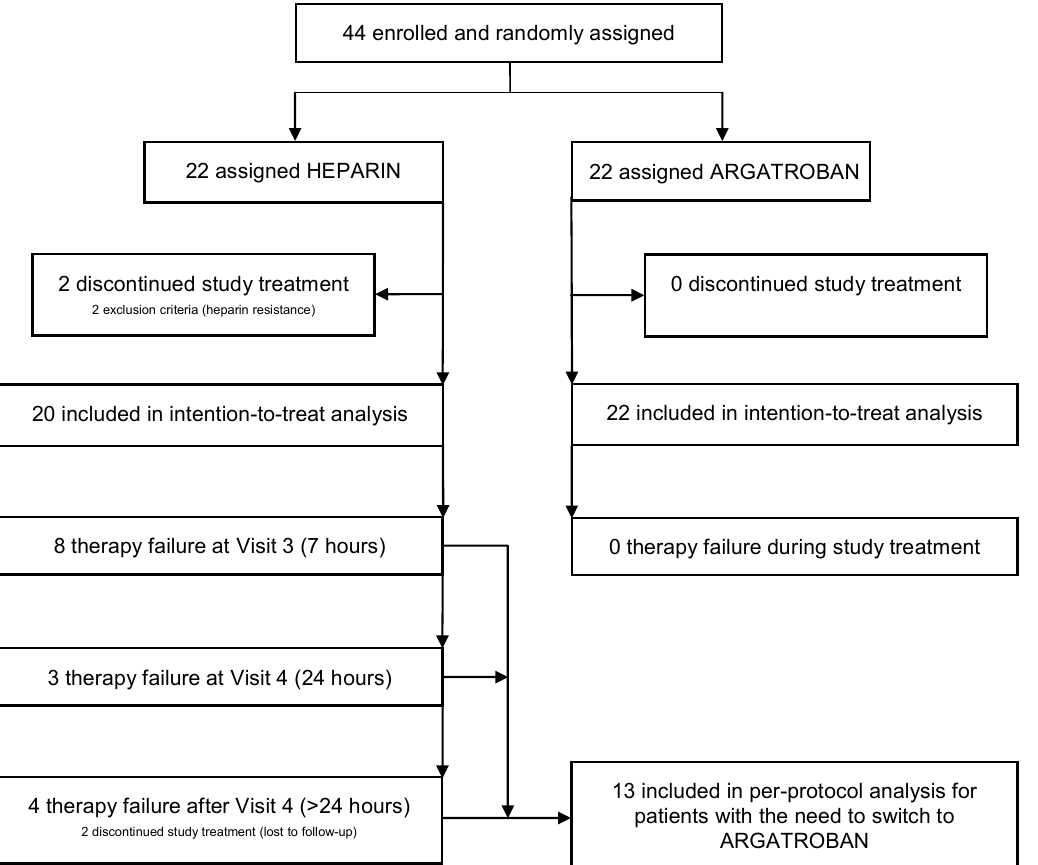
Figure 1. Trial profile Therapy failure in the heparin group = aPTT < 45 s despite maximum heparin dose (1500 IU / h). Therapy failure in the argatroban group = aPTT < 45 s despite maximum argatroban dose (10 µg/kg/min). Table 1. Characteristics a of patients.